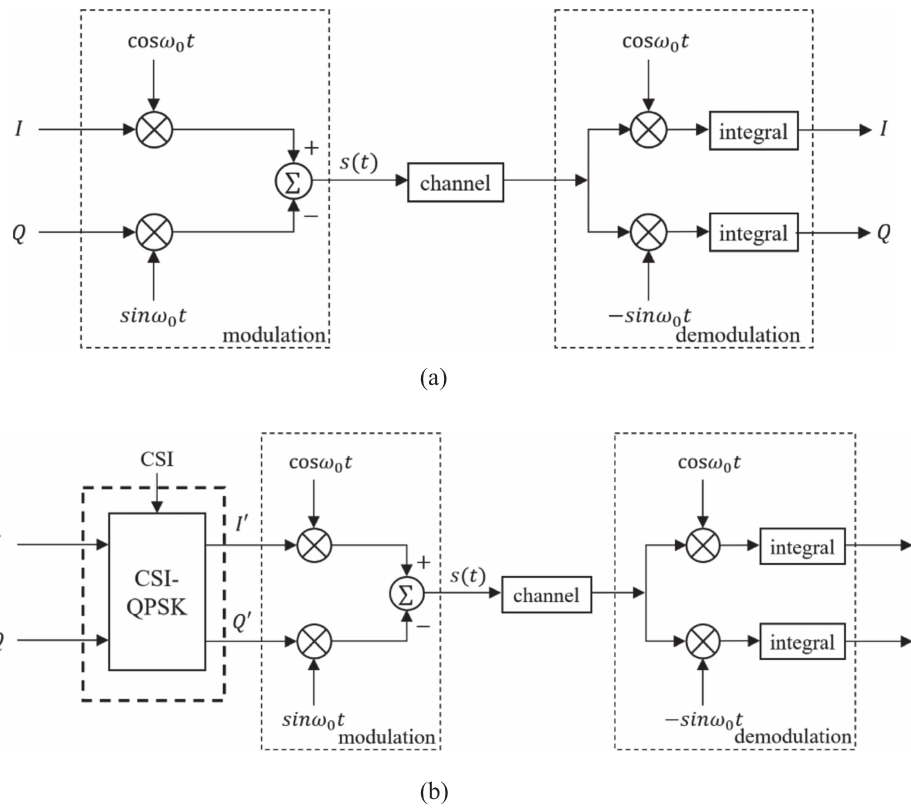
Figure 4. Schematic diagram of traditional QPSK and CSI-QPSK: (a) Schematic diagram of traditional QPSK modulation and demodulation; (b) Schematic diagram of CSI-QPSK method